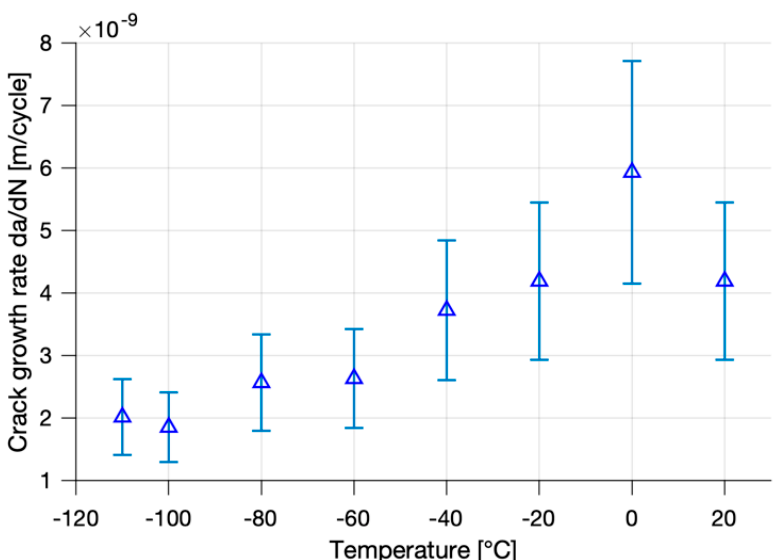
√ m of the S500 steel base